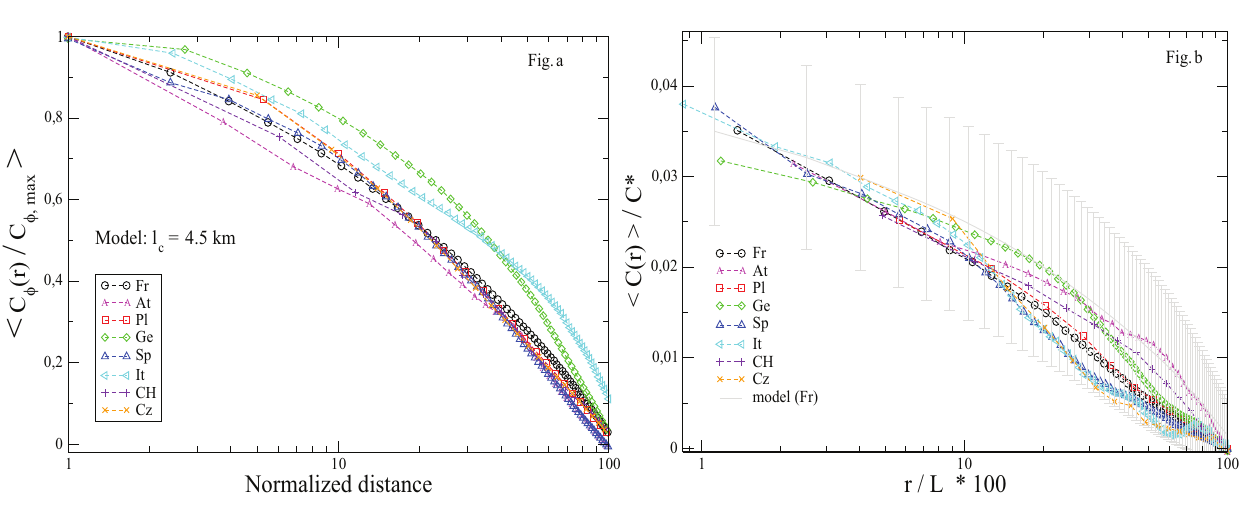
Figure 9. Average of spatial correlation, rescaled. Left: Average over numerical simulations of the model (with ‘ c ~ 4 : 5 km) with the true positions of all cities for each country. Right: Average over real election data for each country. We also shown the average and standard deviation (coming from different realizations of the noise history g , and plotted as error bars) corresponding to the numerical model for French cities.